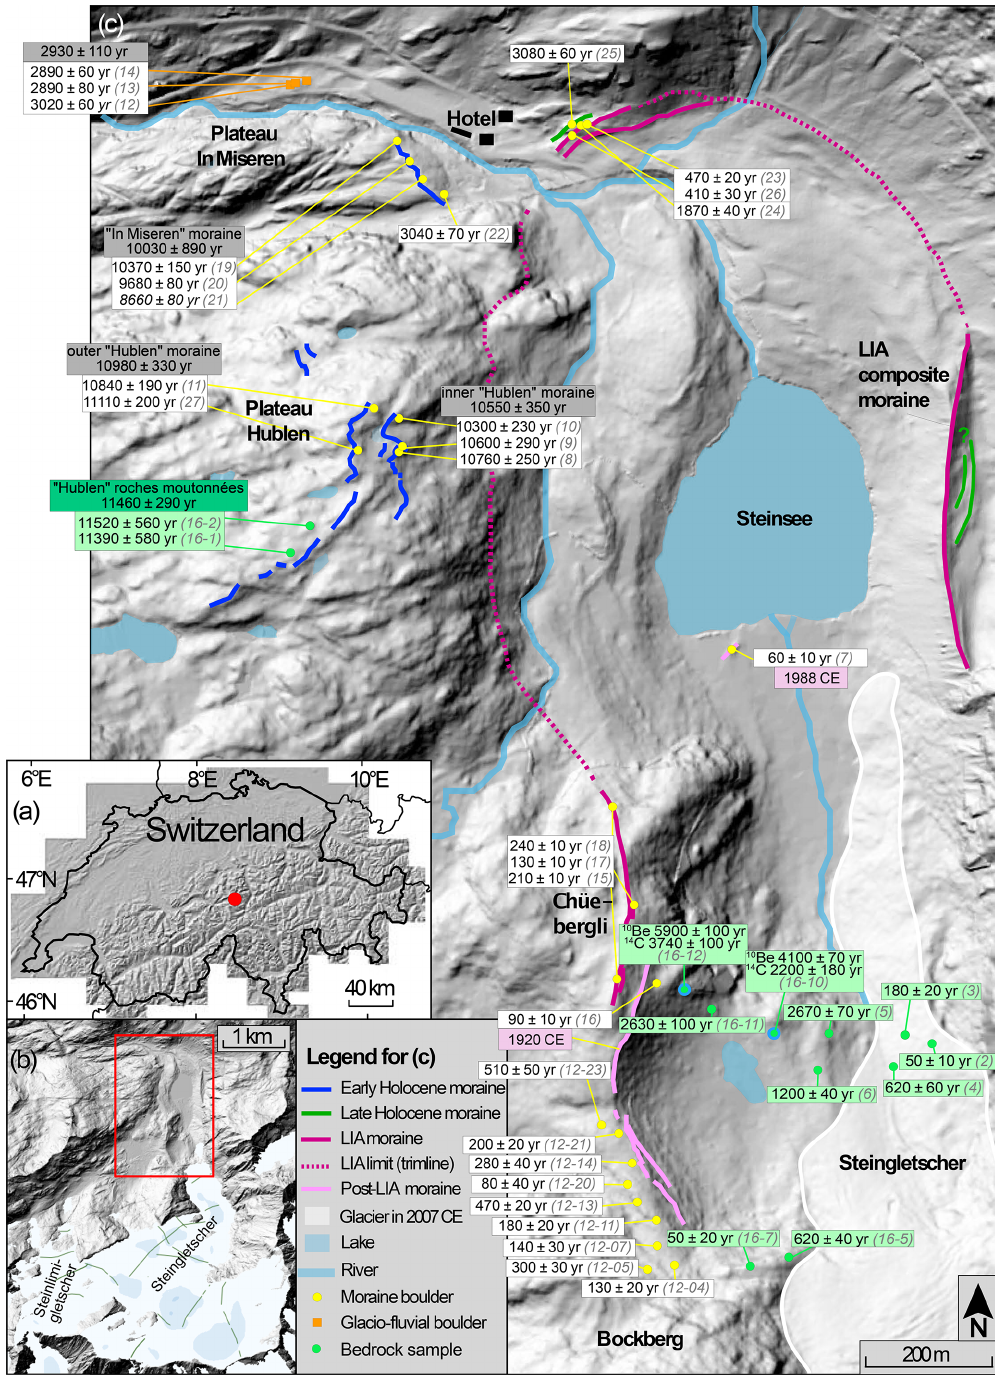
Figure 1. Maps of the study site based on shaded relief ALTI3D models by ©swisstopo. (a) Switzerland and the location of Steingletscher as a red dot (central Swiss Alps, 47 ◦ C). (b) Overview of the whole glacier catchment with the extents of Steingletscher and Steinlimigletscher in the year 2016. The red rectangular corresponds to panel (c) . (c) Steingletscher’s forefield with mapped Holocene moraines, their 10 Be exposure ages and 1 σ analytical uncertainties (white boxes; recalculated from Schimmelpfennig et al., 2014; one outlier in italic), and the new bedrock sample locations with their apparent 10 Be and 14 C exposure durations and 1 σ analytical uncertainties (green boxes). Mean landform ages are shown in darker boxes with 1 σ uncertainties including analytical and 10 Be production rate uncertainties. Pink boxes give years of historically recorded moraine